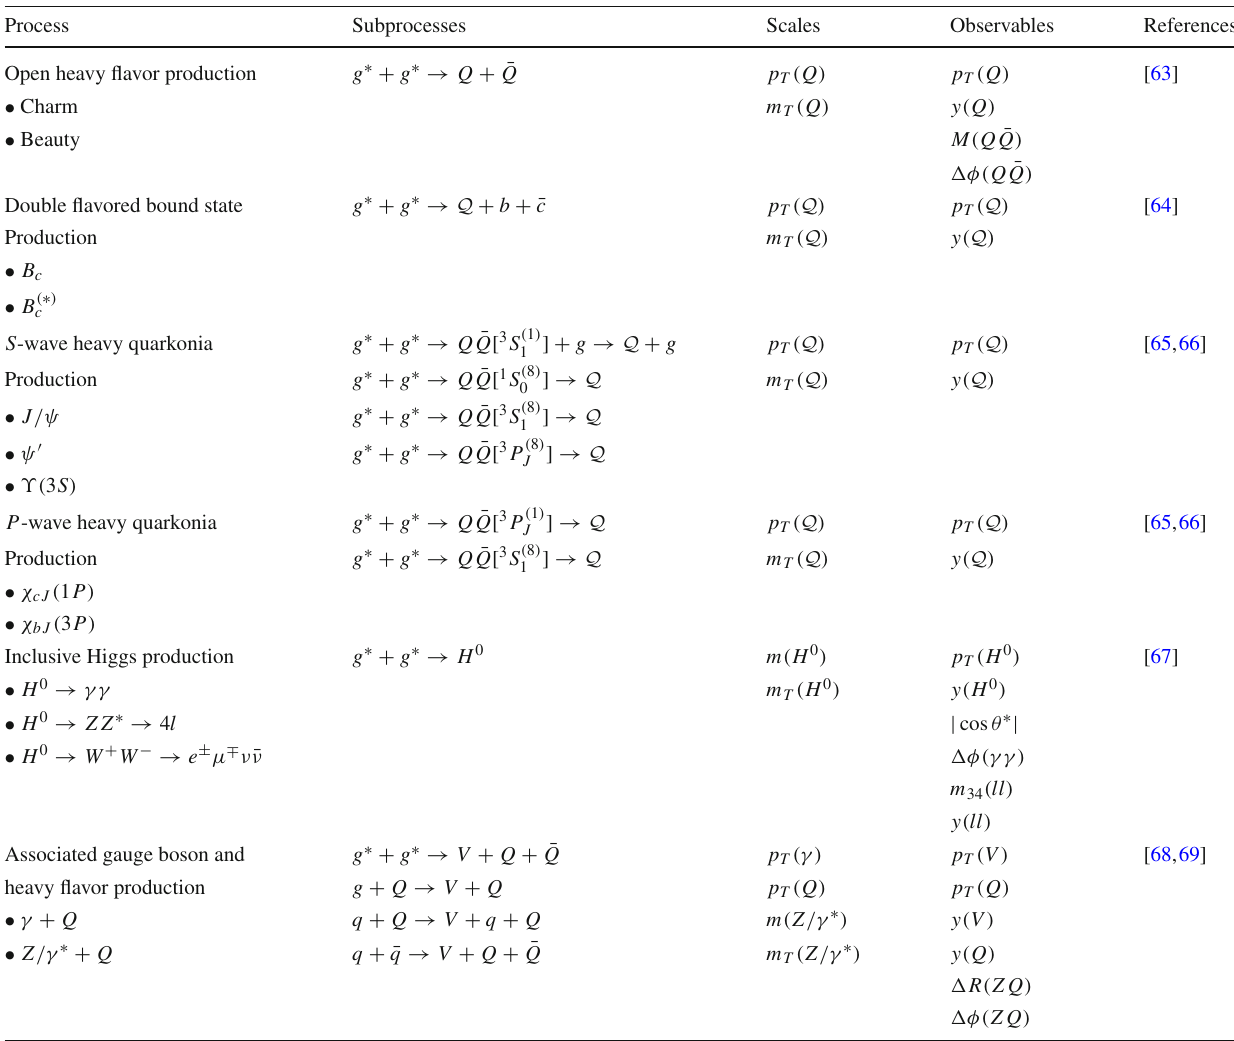
Table 2 List of the available processes. Note that exact definitions of all kinematical variables can be found, for example, in corresponding references Process Subprocesses